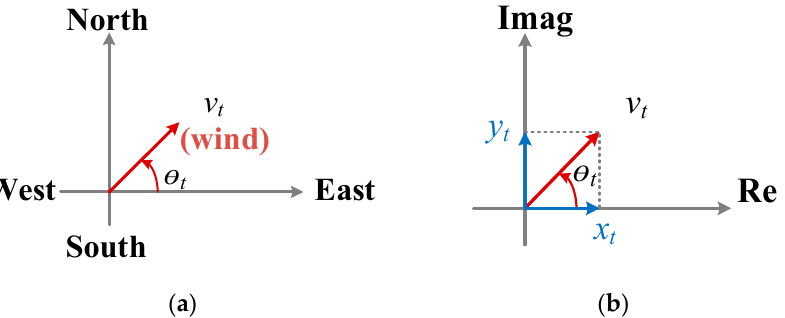
Figure 1. The representation of the wind speed and its direction ( a ) in Vector Form, and ( b ) in Complex Plane.